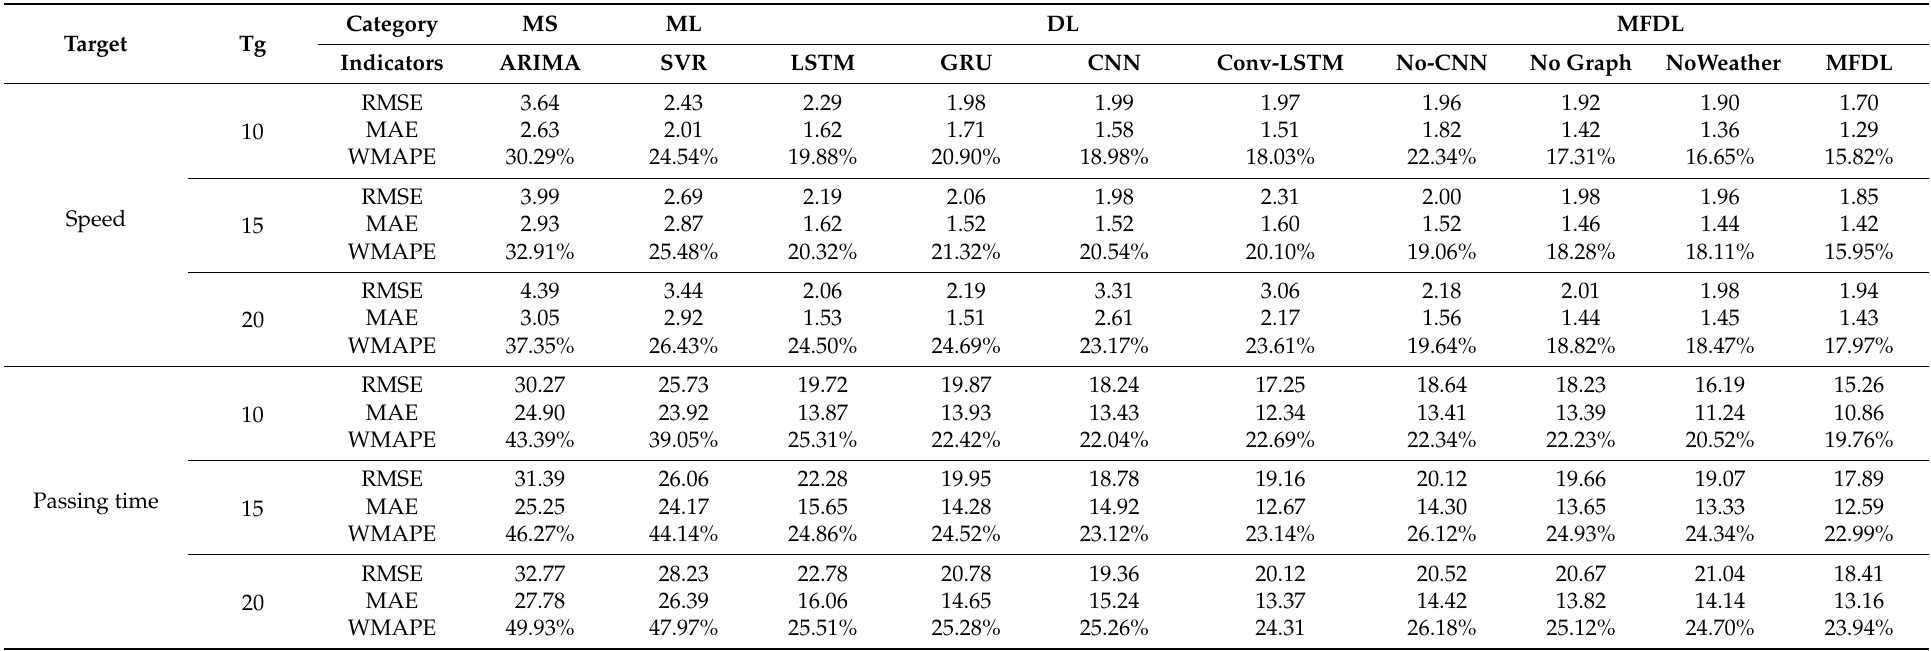
Table 4. Compare the prediction performance with different